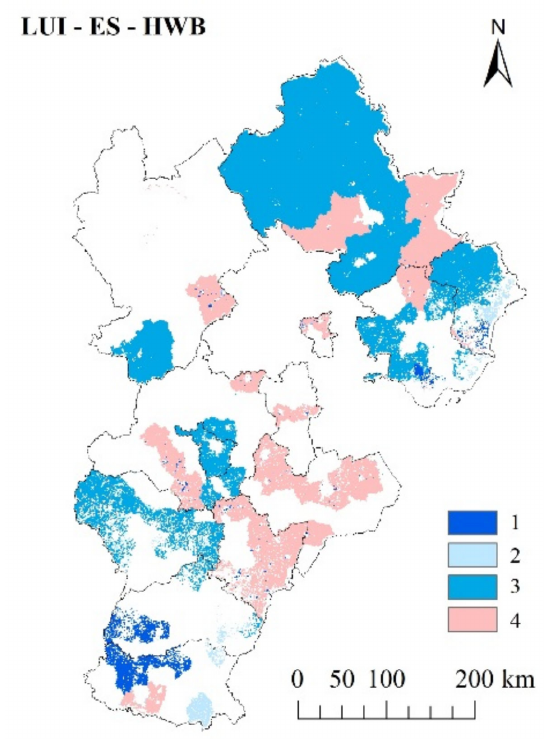
Figure 10. The distribution of trade-offs/synergies among LUI, ESs, and HWB in Hebei during 2000–2015. Note: 1 represents the trade-off between LUI—(ES and HWB), while ES-HWB is synergis- tic; represents the trade-off between ES—(LUI and HWB), while LUI-HWB is synergistic; represents trade-off between HWB—(LUI and ES), while LUI-ES is synergistic; 4 represents synergy among